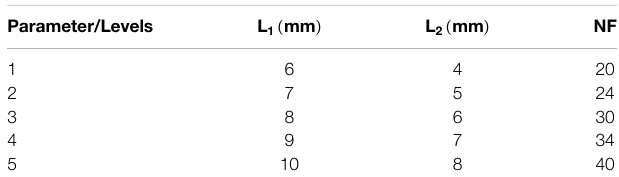
TABLE 2 | Microseperator design parameters and levels.